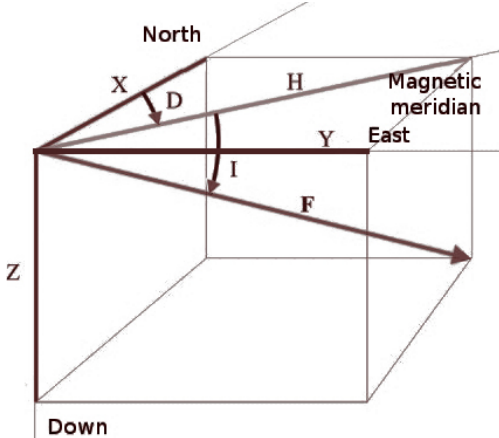
Figure 1. Representation of the three-dimensional geomagnetic vector B